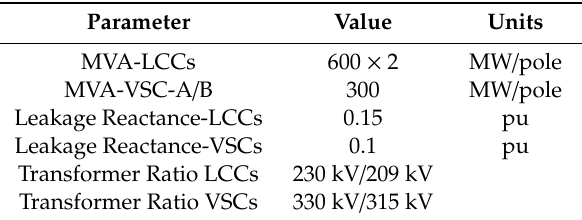
Table 2. Transformer data.